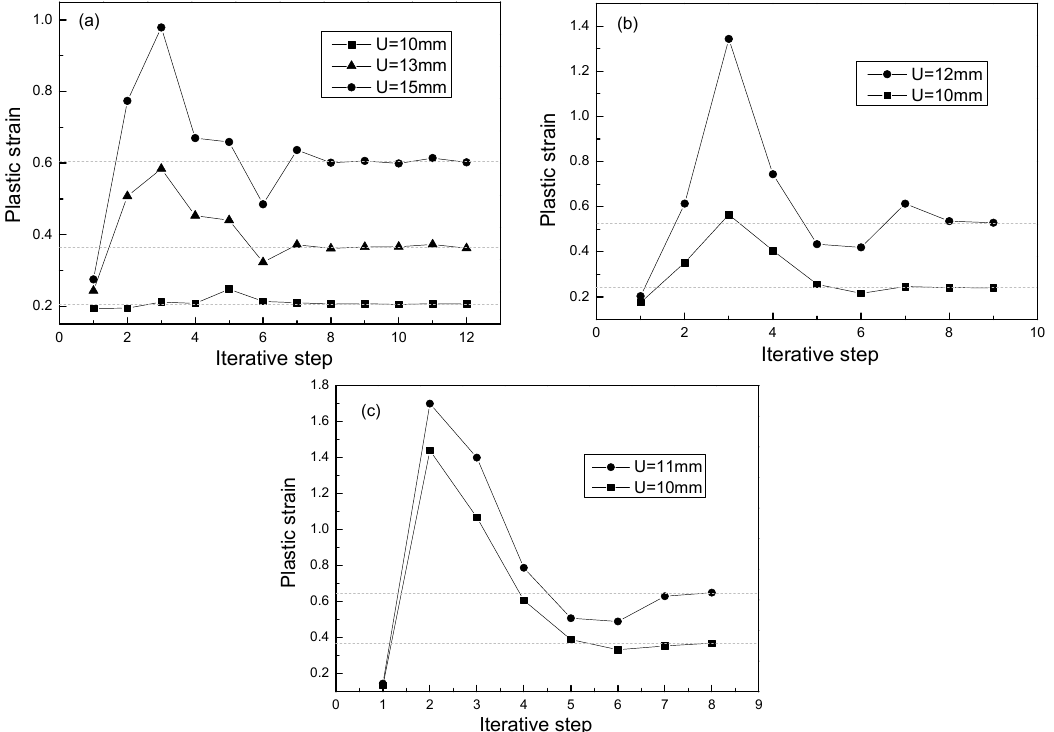
Figure 5. Relationship between elongation and plastic strain at different strain rates ( a ) 0.005 s −1 ( b ) 0.02 s −1 ( c ) 0.1 s −1 .